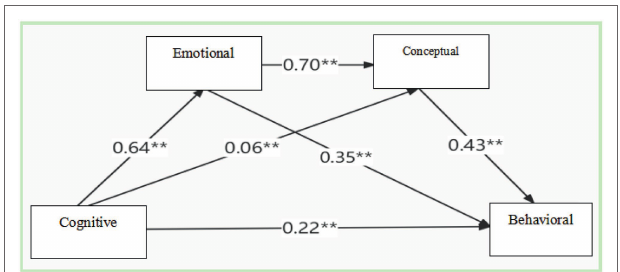
FIGURE 2 | The bootstrap method of deviation correction is used to test the intermediary effect to check whether the intermediary effect is significant. Reset the sampling setting to 2,000 times, and calculate the 95% deviation correction CI. If the 95% confidence interval (95% CI) does not include 0, it indicates that the intermediary effect is significant. The results show that emotional identity and conceptual identity play multiple mediating roles in the relationship between cognitive identity and behavioral identity. ** p <